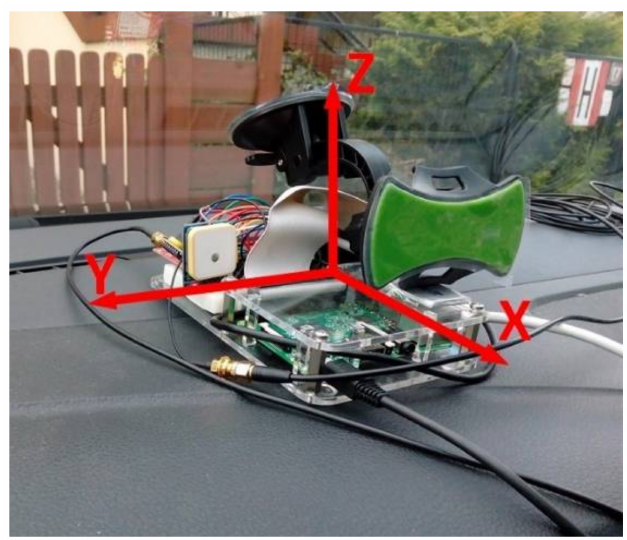
Figure 7. Device prototype mounted in the car, with depicted accelerometer